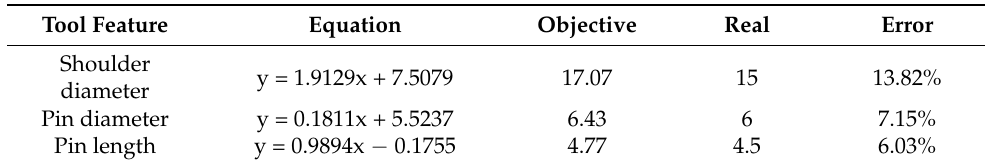
Table 6. Comparison between tool design guidelines and experimental work by other authors for series